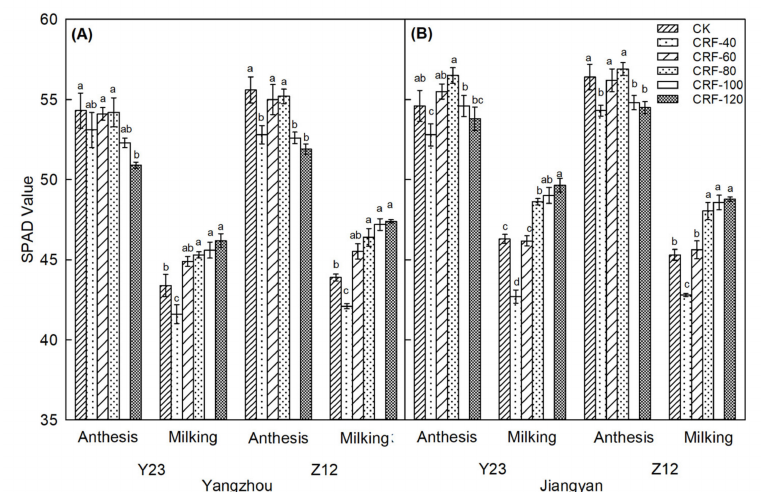
Figure 5. Chlorophyll content (value of SPAD) in wheat flag leaves at the anthesis and milking stages in different CRF treatments in Yangzhou ( A ) and Jiangyan ( B ) sites in 2018–2019. Error bars represent SE of the mean ( n = 6). Different lowercase letters above bars represent significant differences at 0.05 probability level.